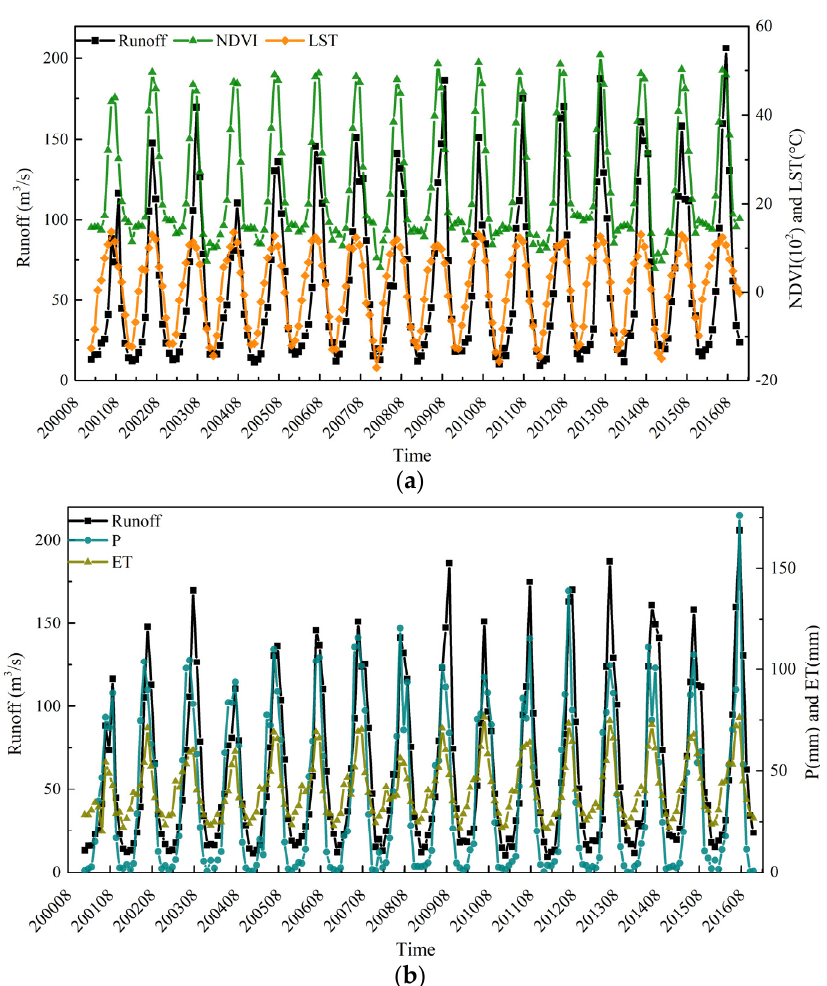
Figure 6. ( a ) The correlation analysis carried out between NDVI, LST, and runoff. The black, green, and orange curves represent the runoff, NDVI, and LST, respectively. ( b ) The correlation analysis between P(RS), ET, and runoff. The black, green, and blue curves represent the runoff, ET, and P, respectively.